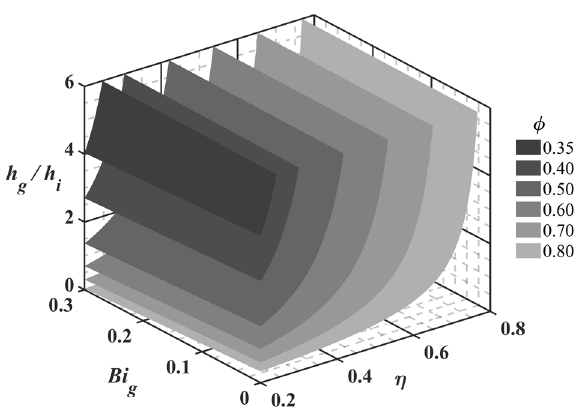
Figure 2. Isosurface of overall cooling effectiveness.